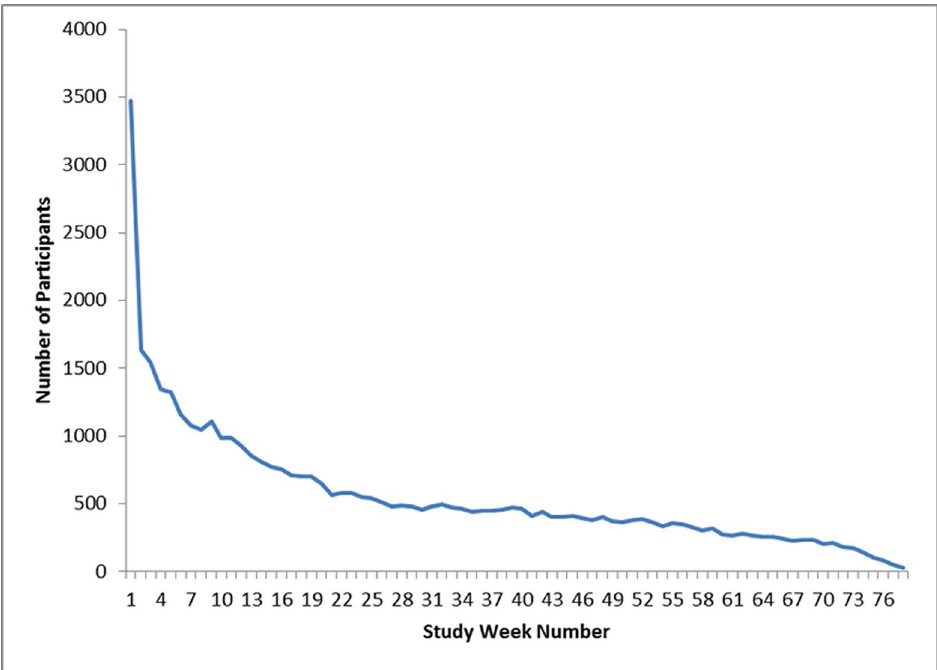
Fig 4. Total number of participants using the device over time (by study week number). Week 1 on the x-axis refers to the participant’s first week of using the device. The y-axis indicates the number of participants recordings at least one use of the device during each week they were in the